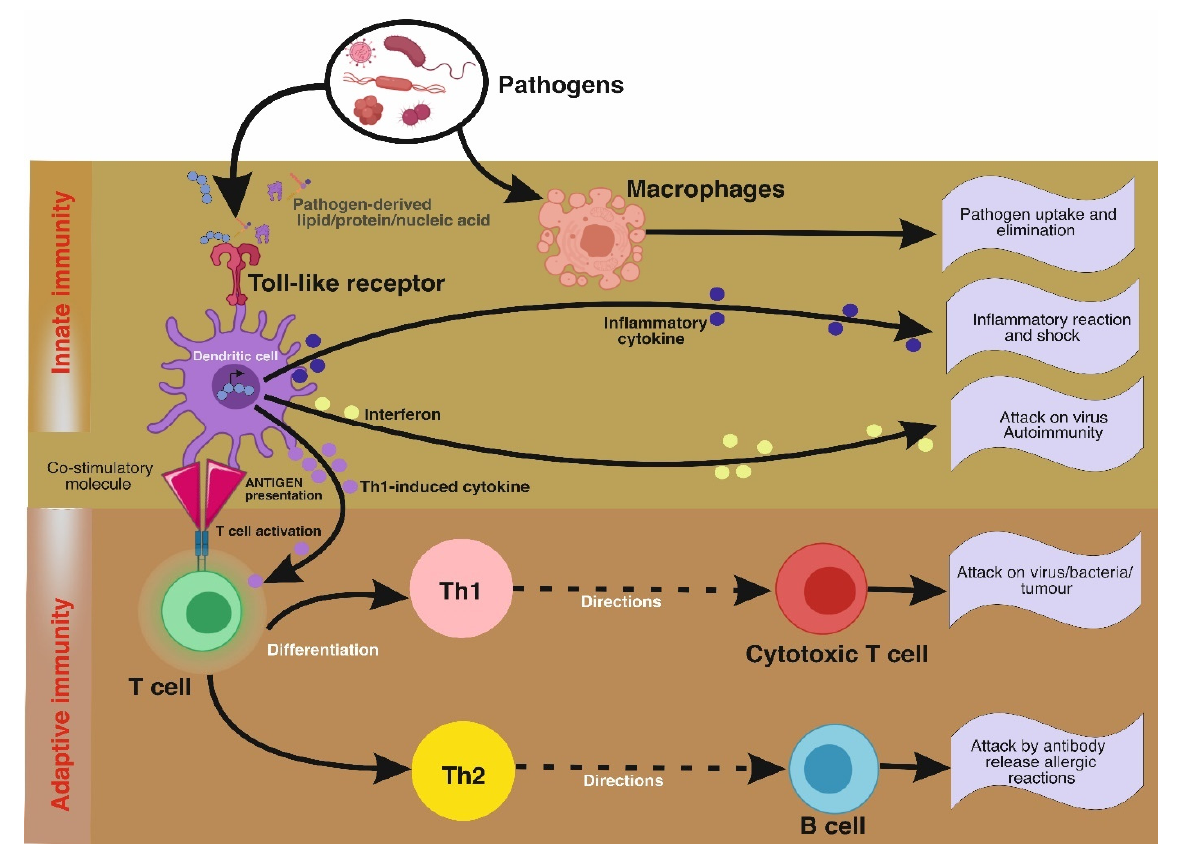
Figure 2. The schematic diagram for the mechanism of innate and adaptive immunity; activity of mushroom extracts on cyclic pathways, adapted from [115].